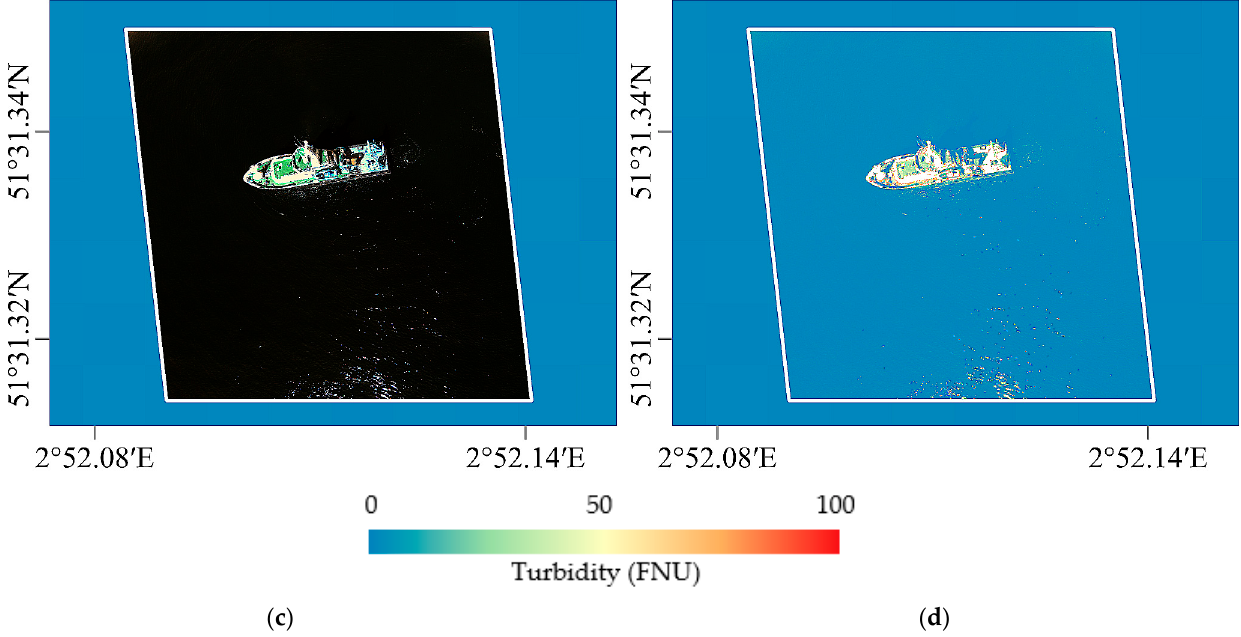
Figure 9. True colour and turbidity products for the two locations. Sentinel-2-derived turbidity products serve as a background. ( a ) True colour drone image at location A, acquired at 10:05 UTC; ( b ) turbidity-derived product at location A; ( c ) True colour drone image at location B, acquired at 12:32 UTC; ( d ) turbidity-derived product at location B. Table 4. Turbidity values derived from Sentinel-2 MSI, DJI PH4pro and HACH in situ device for the two locations in the Belgian North Sea.